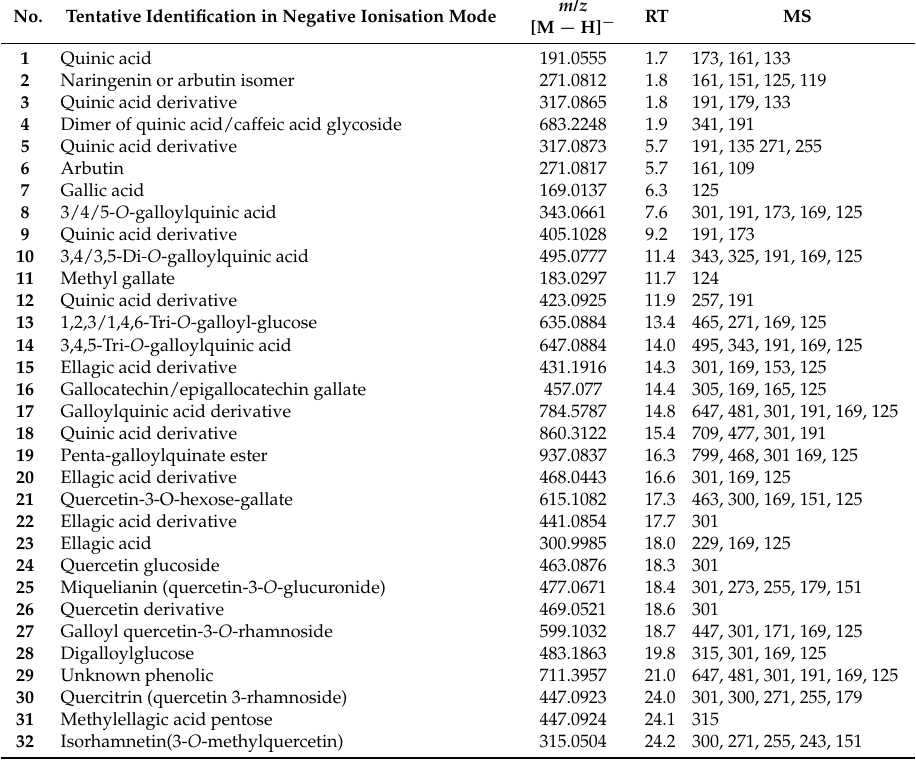
Table 1. Tentative phenolic compound identifications based on the MS/MS spectra in both the negative and positive ionisation modes. Numbers 1 to 32 (negative; upper section of the table) and 1 to 9 (positive; lower section of the table) correspond to the peaks annotated in Figure 3. RT = retention time. m / z No. Tentative Identification in Negative Ionisation Mode [M − H] −